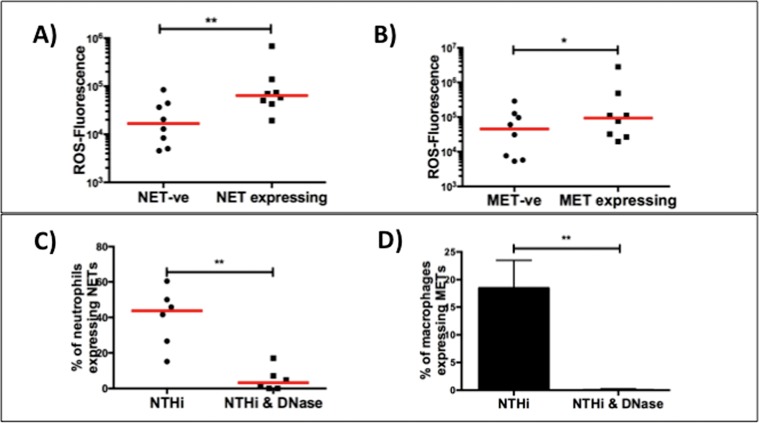
Production of extracellular traps is associated with ROS production and is inhibited by DNase.Panels A shows that neutrophils expressing NETs have a four-fold increase in ROS fluorescence compared to NET negative (-ve) cells (NET-ve 16 706 (5879–42 332), NET+ve 64 146 (44 738–122921)), (n = 7, p = 0·008). Panel B shows that macrophages expressing MET-like structures have a two-fold increase in ROS fluorescence compared to MET negative (-ve) cells (MET-ve 45 644 (6257–118907), MET+ve 93 636 (28 113–392 973)), (n = 8, p = 0·023). Panels C and D demonstrate inhibition of NET (NTHi 44 (24–53), NTHi & DNase 3 (0–10)), (n = 6, p = 0·004) and MET-like structure (NTHi 19±5, NTHi & DNase 0.1±0.1)), (n = 8, p = 0·008) formation by the addition of DNase.